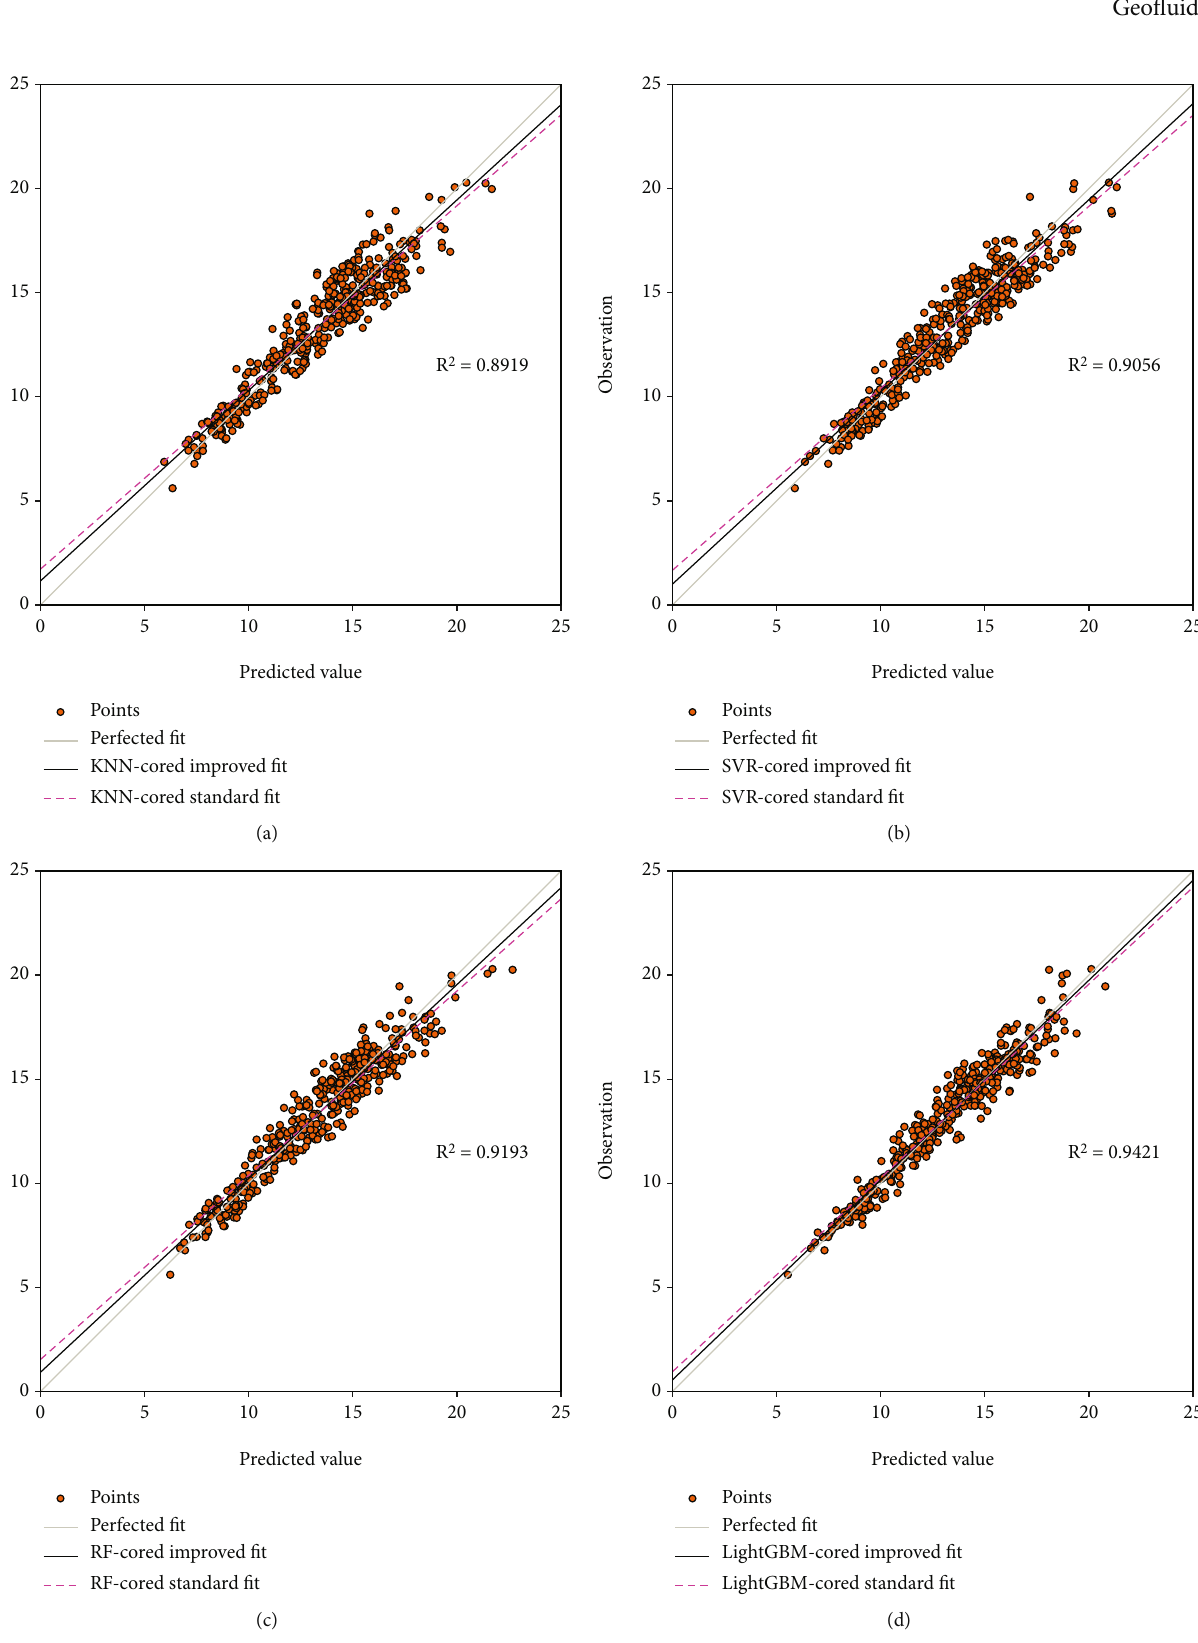
Figure 12: Fitness of porosity results provided by KNN-cored predictor (a), SVR-cored predictor (b), RF-cored predictor (c), and LightGBM-cored predictor (d) in the second experiment. “ standard fi t ” means the fi tting is gained in the fi rst experiment; KNN =k- nearest neighbors; SVR =support vector regression; RF =random forest; LightGBM=light gradient boosting machine; RMSE=root- mean-square